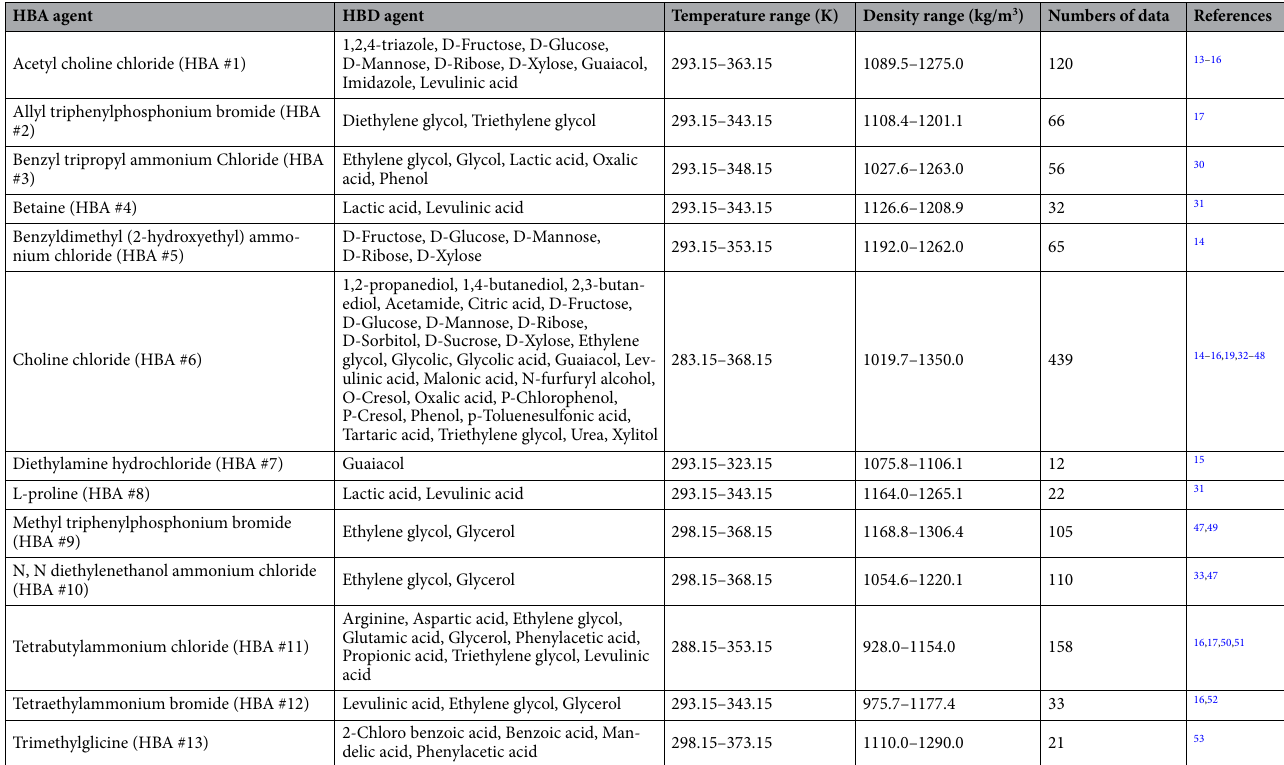
Table 1. Summary of the reported laboratory-measured density for diverse deep eutectic solvents in the